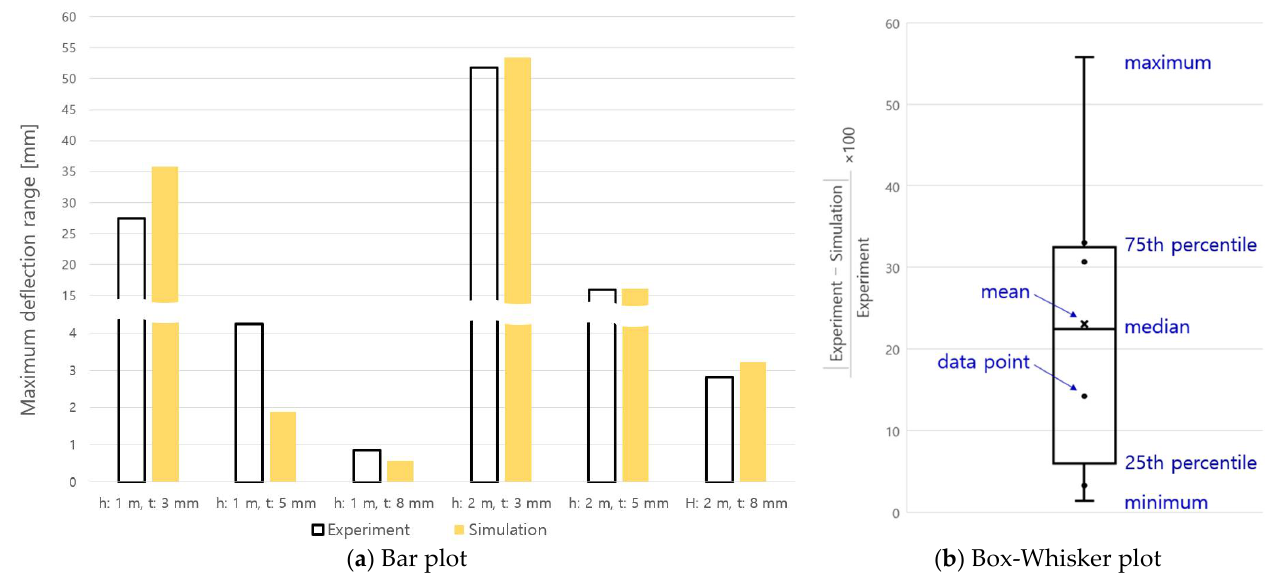
Figure 13. Comparison of maximum deflection ranges.